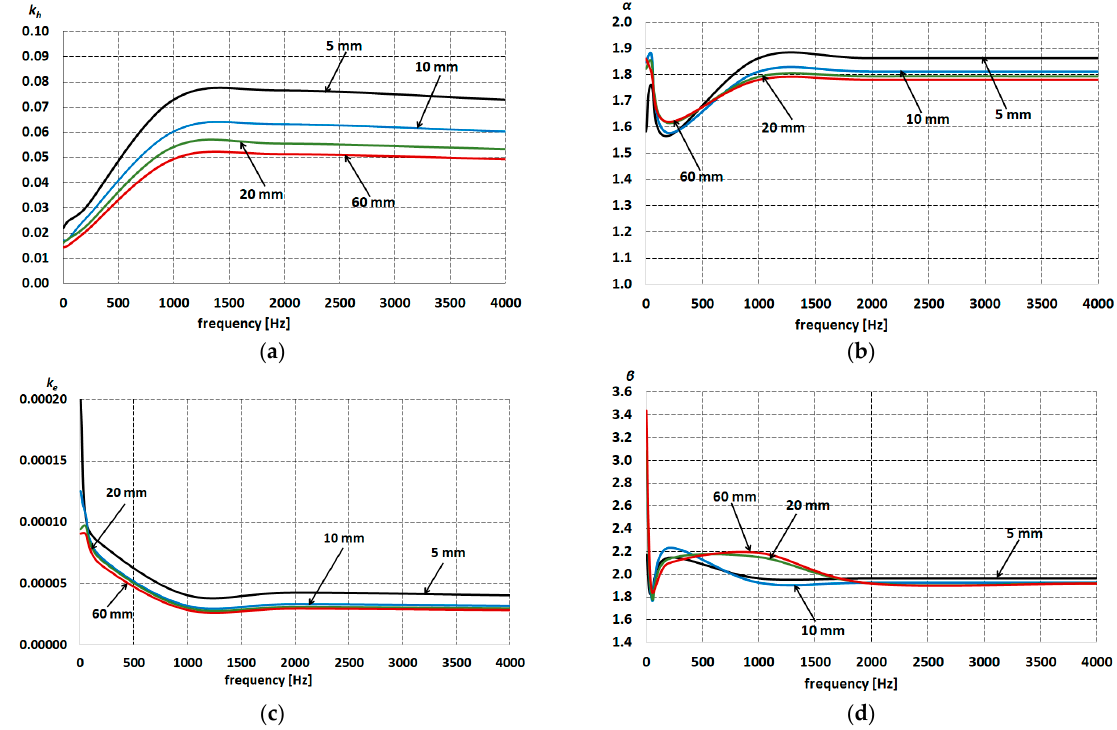
Figure 7. Courses of coefficients ( a ) k h ; ( b ) α ; ( c ) k e ; ( d ) β as a function of frequency for individual widths of M270-35A sheet samples cut with a guillotine.